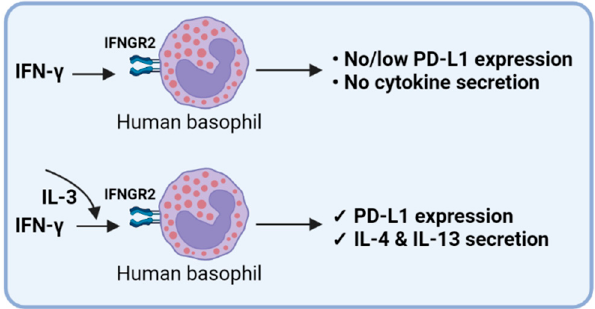
Figure 7. IFN- γ -induced PD-L1 expression in human